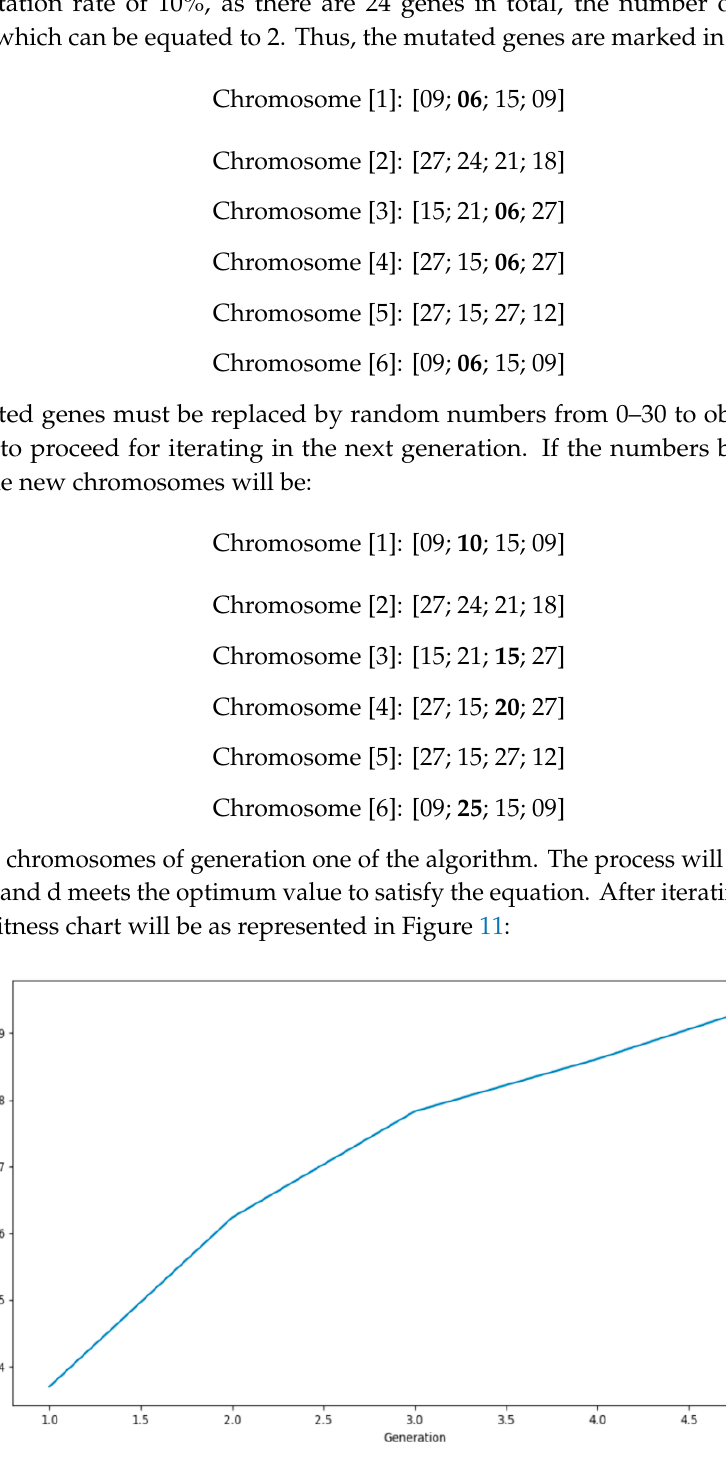
Figure 11. Evolution fitness curve showing gradual increase in fitness value corresponding to the generation.